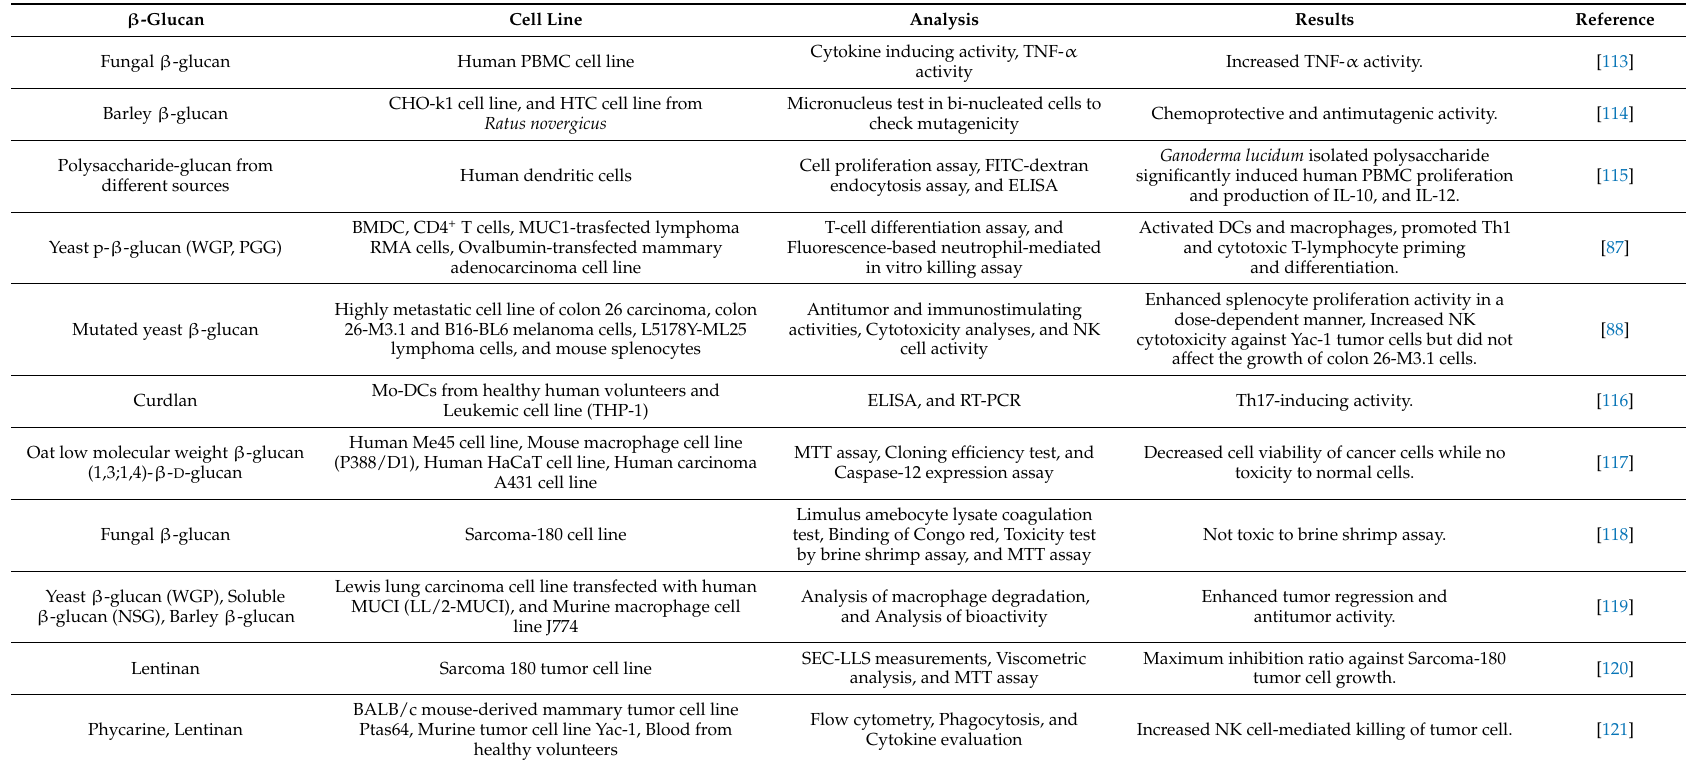
Table 2. Antitumor effects of β -glucans—in vitro